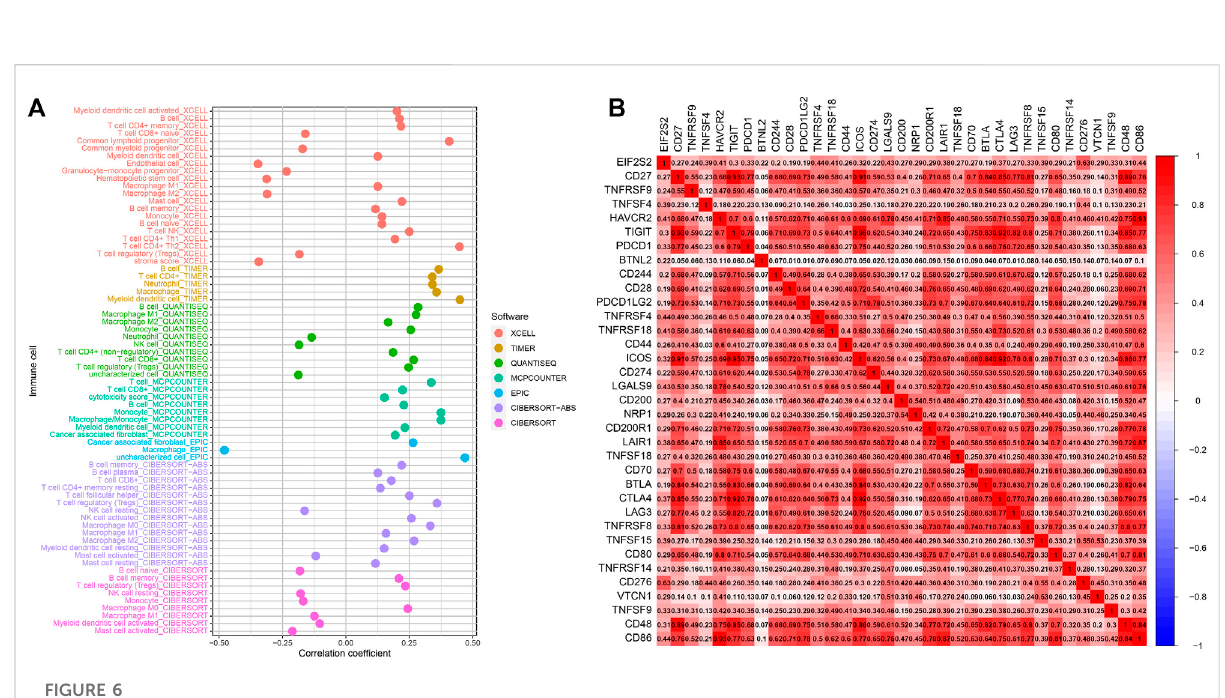
FIGURE 6 Results of correlation between EIF2S2 expression and immunity. (A) Correlation between EIF2S2 expression and immune cell in fi ltration. (B) Correlation of EIF2S2 expression and immune checkpoint